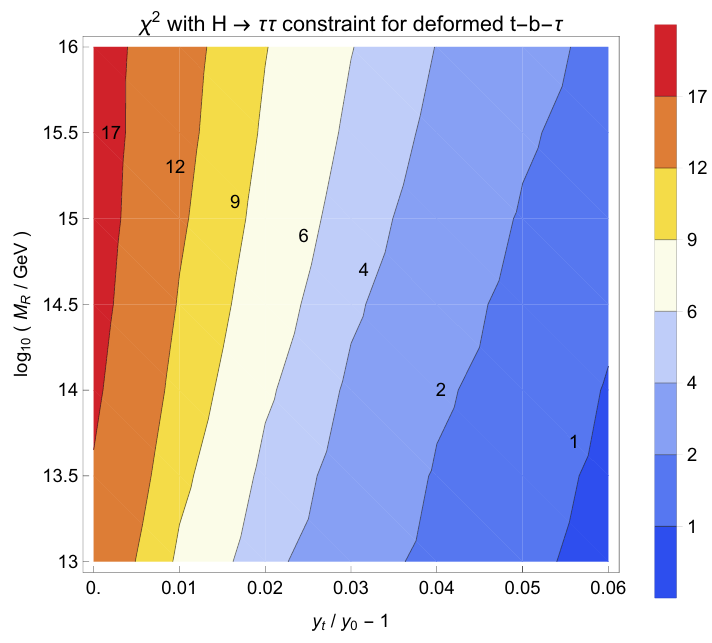
Figure 13 . The contour lines of minimal (cid:31) 2 achieved by SO(10) boundary conditions for a (cid:12)xed t - b deformation y t =y 0 (cid:0) 1 and (cid:12)xed scale M R of the right-handed neutrino of the 3rd family. The (cid:31) 2 includes the constraint from ditau decays of H 0 =A 0 , thus requiring a large m deformations substantially help with the (cid:12)t, and to a smaller degree a lower M R does as